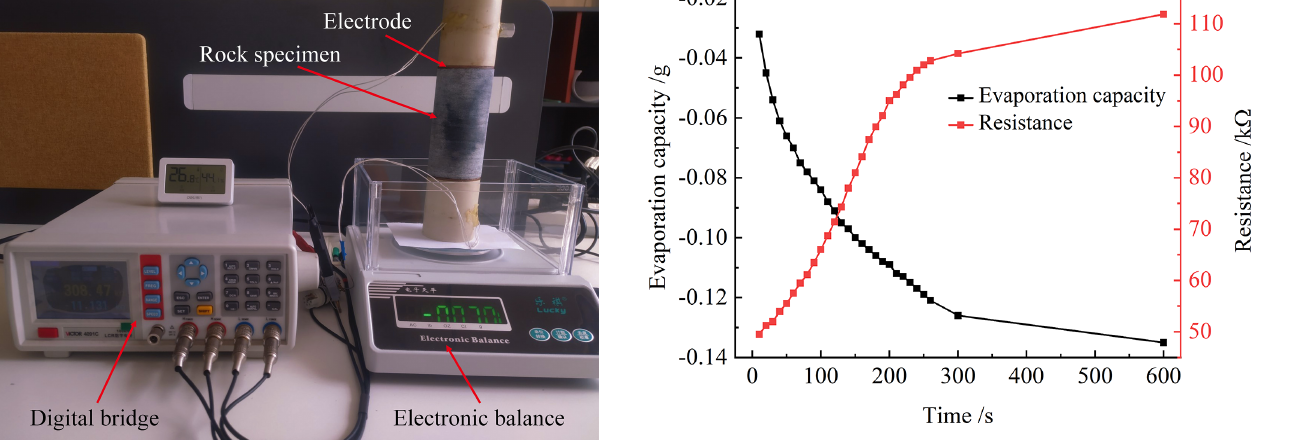
Figure 4. Water film impact test system.